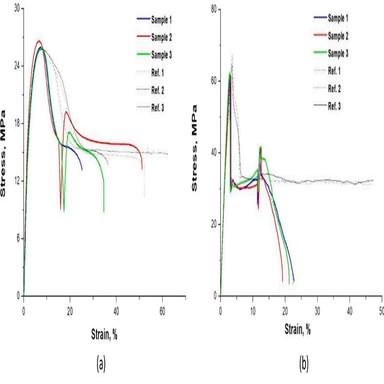
Stress-strain curves related to irradiated HDPE (a) and PET samples (b).